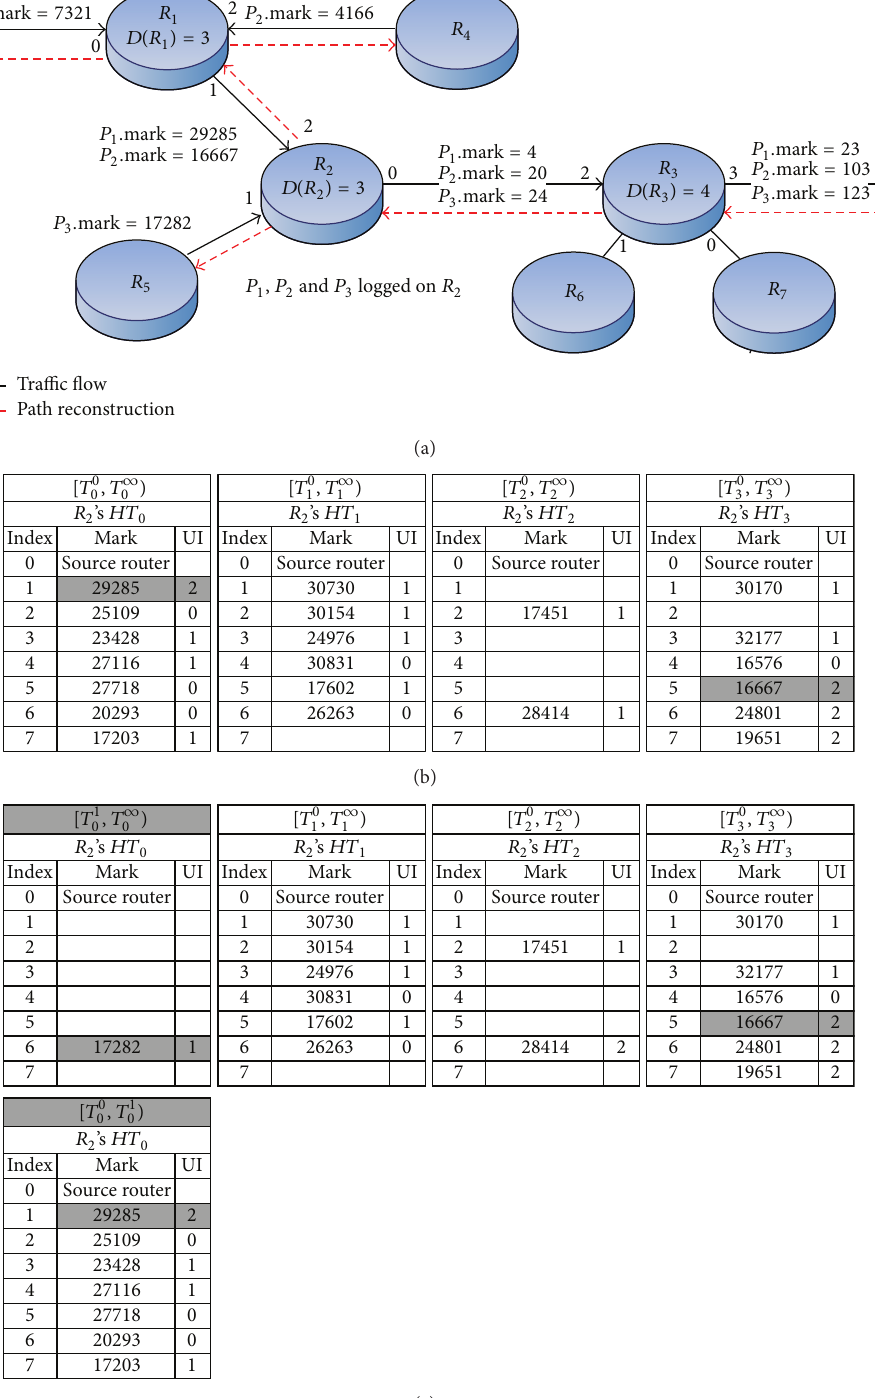
Then, we find the new entry’s index 𝑙 = (6 + 0.5 × 5 + 0.5 × 5 2 ) % 8 = 5 . Hence, 𝑅 𝐻𝑇 5 3 ; see the grey cells of